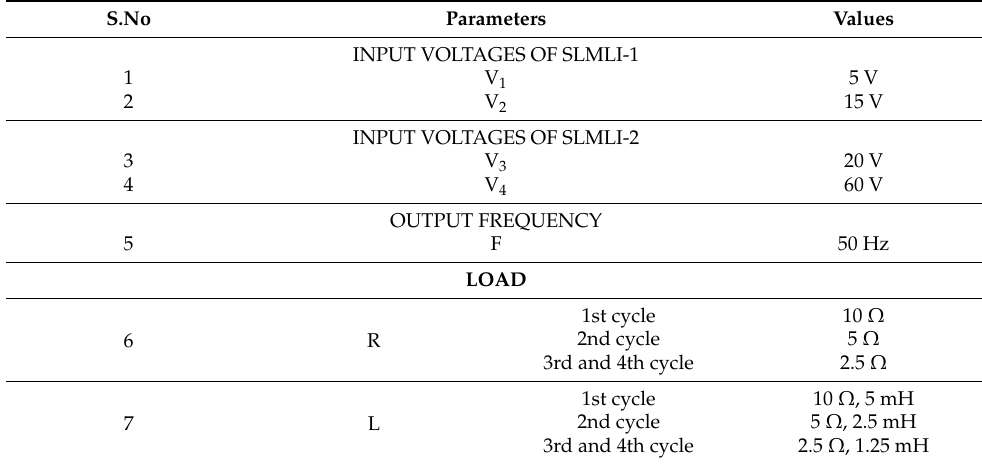
Figure 5. ( a ) Pulse waveforms for stage-1; ( b ) pulse waveforms for stage-2. Table 5. Specification of two stage SLMLI.